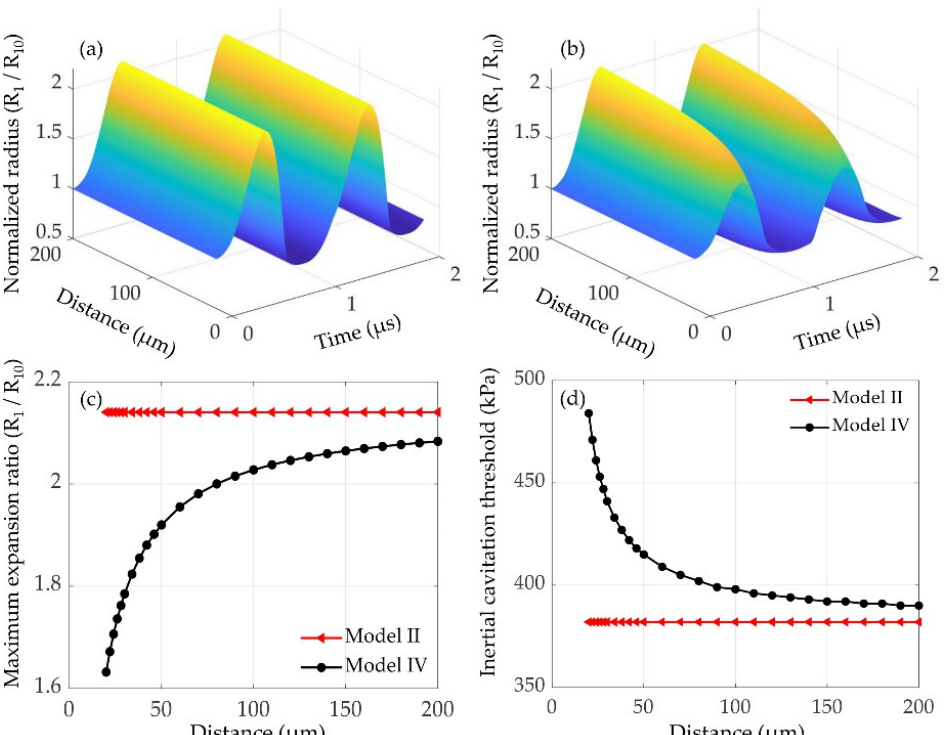
Figure 7. Effects of bubble − bubble interactions on the dynamics and inertial cavitation threshold of the small lipid-coated bubble ( R 10 = 1 µ m) at different inter-bubble distances ( d i,j = 20 µ m − 200 µ m, p A = 400 kPa, R 20 = 5 µ m), including the normalized radii as a function of time ( a ) without (model II) and ( b ) with (model IV) considering the inter-bubble interactions, ( c ) the maxima of the normalized radii and ( d ) the inertial cavitation threshold as function of the inter-bubble distance. Considering that the size of microbubble might affect the cavitation dynamics, and then affect the oscillations of nearby microbubbles, therefore the effects of the initial radius of a large lipid-coated microbubble on the dynamics and inertial cavitation threshold of a 1 µ m lipid-coated microbubble were examined. Normalized radius of the microbubble as a function of time without and with considering the inter-bubble interactions at different initial radii of the nearby microbubbles are shown in Figure 8a,b, respectively. Furthermore, the maximum expansion ratios in both cases are presented in Figure 8c. It shows that the oscillations and maximum expansion ratios of the isolated microbubble under all conditions are constant, whereas the bubble oscillations and maximum expansion ratios with considering the inter-bubble interactions decrease gradually as the initial radius of the nearby microbubble increases. Consequently, as shown in Figure 8d, the inertial cavitation threshold of the affected microbubble is higher than that of the isolated microbubble, and the difference of inertial cavitation threshold becomes much larger with the initial radius of the nearby bubble increasing. It can be explained that stronger suppression effects exert on the small bubble when the nearby microbubble has a larger bubble